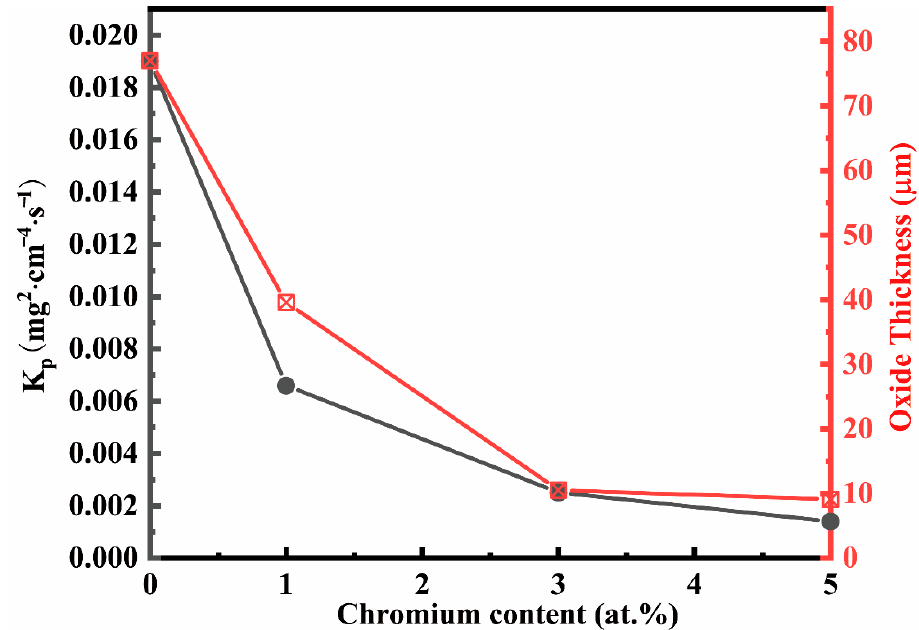
Figure 6. The plot of oxide scale thickness and parabolic rate constant as a function of Cr concentration for the four alloys at 900 °C for 100 h is shown in Figure 5, and the red font is the oxide thickness. The analysis of oxidized samples’ microstructure in the cross-section shows differ- pact oxide scales. Therefore, the formation of protective spinel oxide scales is conducted with increasing chromium addition, which favors better oxidation resistance.